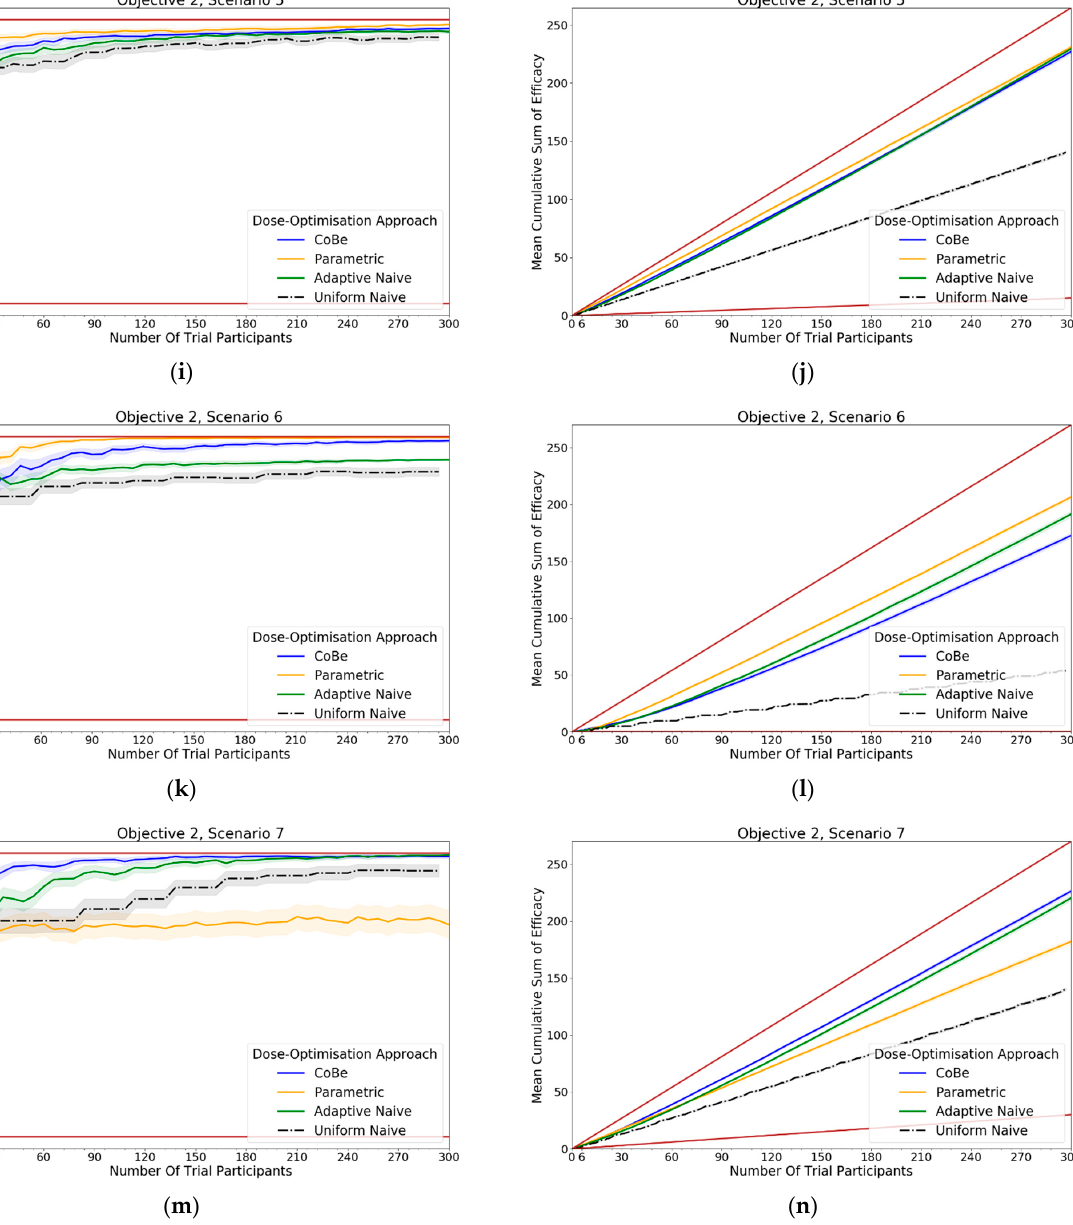
Figure 11. Mean true efficacy at the predicted optimal dose (left) and mean cumulative sum of efficacy (right) against trial size for all seven objective 2 scenarios (Scenario 1 ( a , b ), Scenario 2 ( c , d ), Scenario 3 ( e , f ), Scenario 4 ( g , h ), Scenario 5 ( i , j ), Scenario 6 ( k , l ), Scenario 7 ( m , n )). These are the mean values and 95%CI values across 100 simulations. For the true efficacy plots (left), the brown lines show the minimum and maximum possible efficacy that could be achieved in that scenario. For the cumulative efficacy plots (right) the brown lines represent the maximum and minimum cumulative efficacy sum that could be expected for that scenario. For all scenarios, the CoBe (Correlated Beta) DOA had similar or greater mean true efficacy relative to the other DOAs for most trial sizes (Figure 11, LHS). The mean true efficacy curve typically plateaued with between 60 and 90 trial participants.